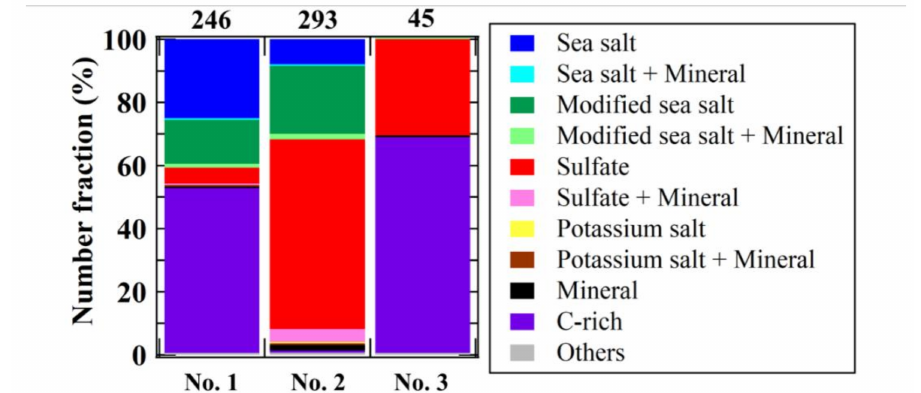
Figure 3. Number fractions of particles for each sample. The above numbers show the number of analyzed